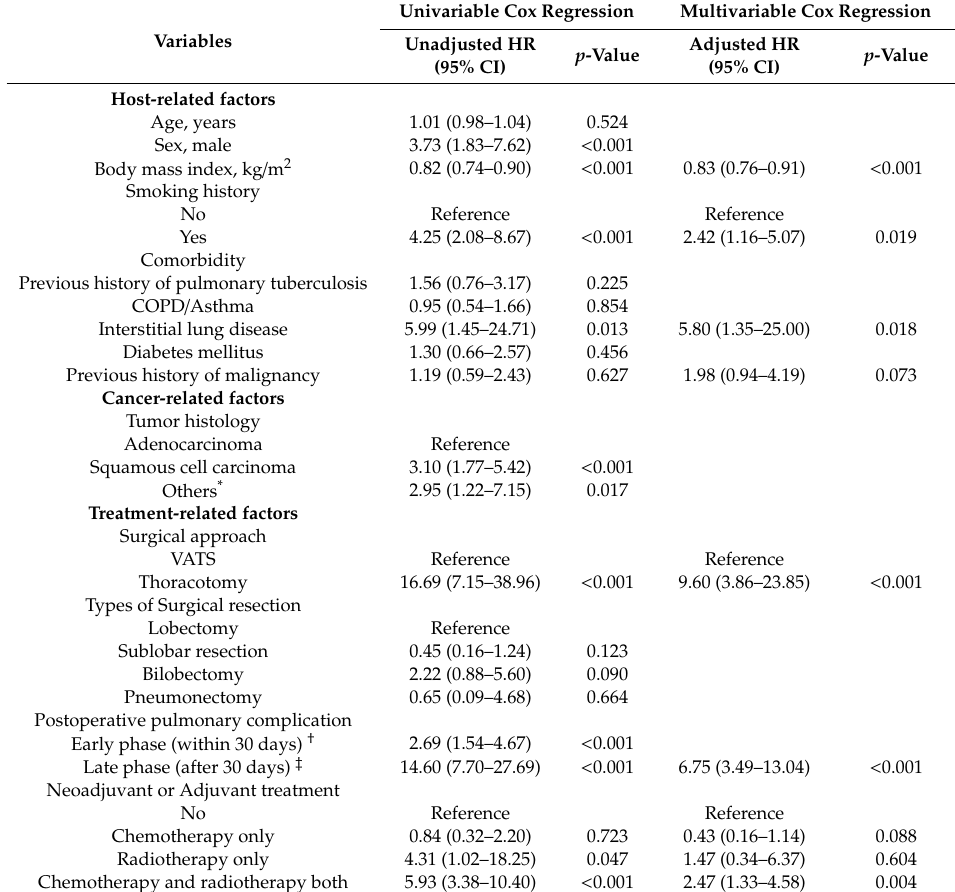
Table 3. Prognostic factors associated with the development of chronic pulmonary aspergillosis after lung resection for NSCLC ( n =